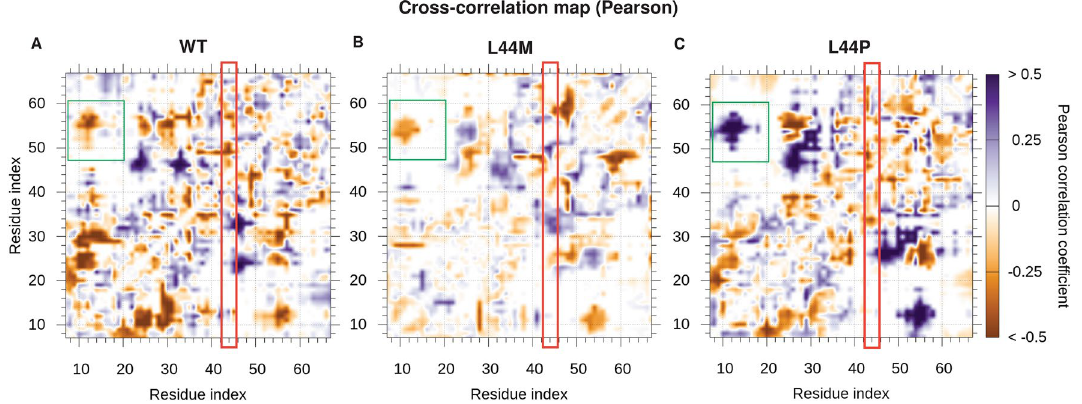
Figure 3. Cross-correlation between residue pairs of LIM1 domain. Pearson correlation method was used by CONAN tool for WT, L44M and L44P trajectories. Anti-correlated residues pairs are colored in brown shade while correlated residues pairs are shown in blue color shades. Red outlined box indicates L44 region. Green outlined box indicates residue correlation differences between WT, L44M and L44P